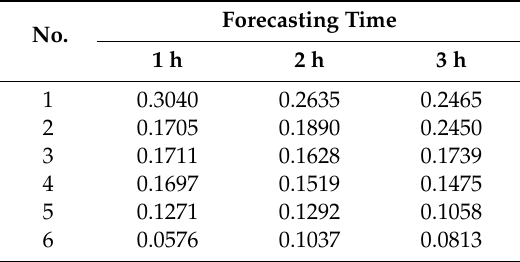
Figure 6. Behavior of the RMSEs (root mean square errors) estimated for the 10 target times and their average.